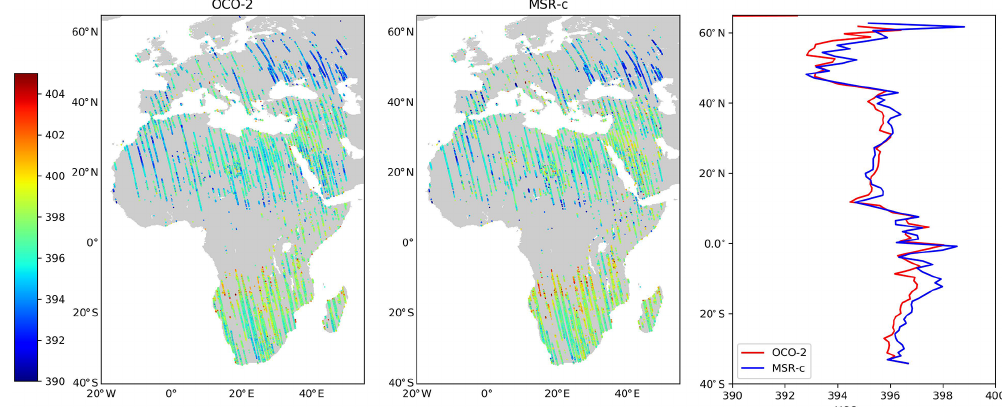
Figure 6. XCO 2 retrievals over Europe, the Middle East, and Africa using OCO-2 and MSR-c measurements. We processed all orbits obtained by OCO-2 between 8 September and 31 October 2014. For each type of retrieval, the corresponding mean bias in Table 5 is subtracted. In the right panel, we include latitude variation in XCO 2 averaged over longitude.